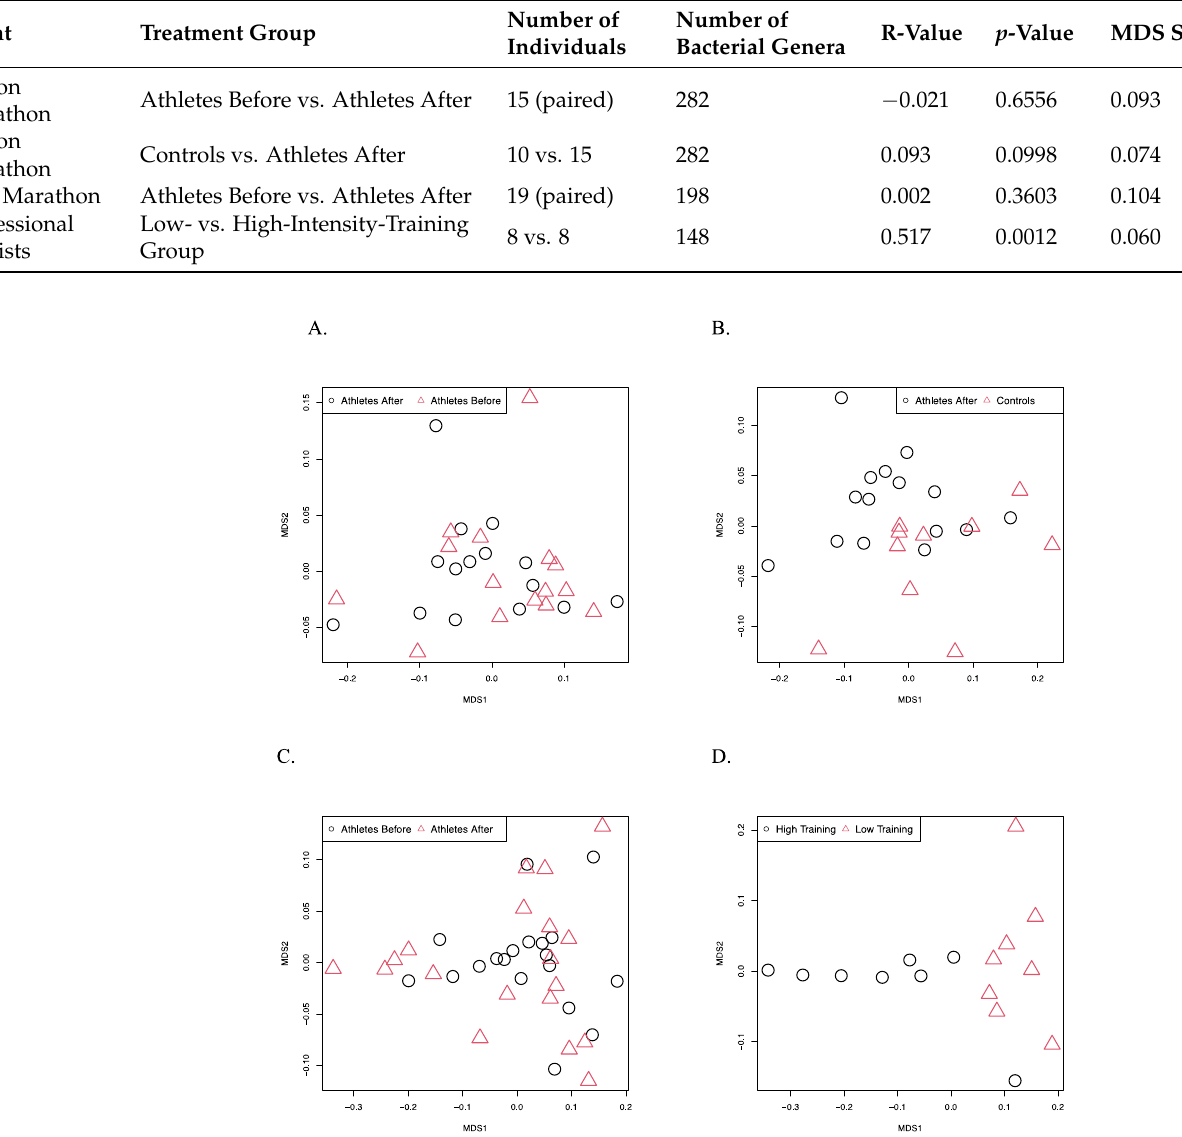
Figure 2. MDS plots of ANOSIM distances for the four datasets. ( A ) = Athletes Before vs. Athletes After Boston Marathon. ( B ) = Controls vs. Athletes After Boston Marathon. ( C ) = Athletes Before vs. Athletes After Half Marathon. ( D ) = Cyclists Low- vs. High-Training Groups.